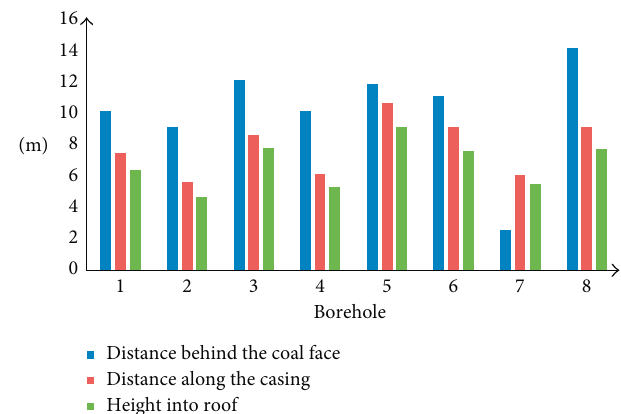
Figure 15: Data for borehole failure position along the borehole, height into the roof, and distance behind the coal face where the borehole failed.